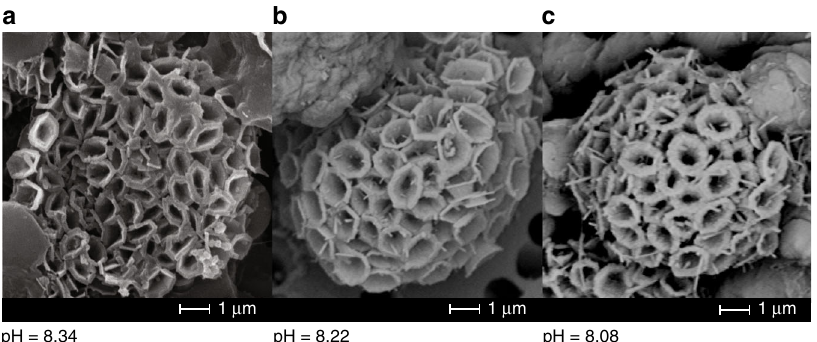
Fig. 7 Scanning electron images of typical O. neapolitana coccolithophores from the three p CO 2 treatments. Electron images do not reveal differences in sizes of coccoliths and coccospheres under different p CO 2 treatments. The effective culture seawater pH values are ( a ) 8.34, ( b ) 8.22, and ( c ) 8.08. Scale bars are 1 μ m in